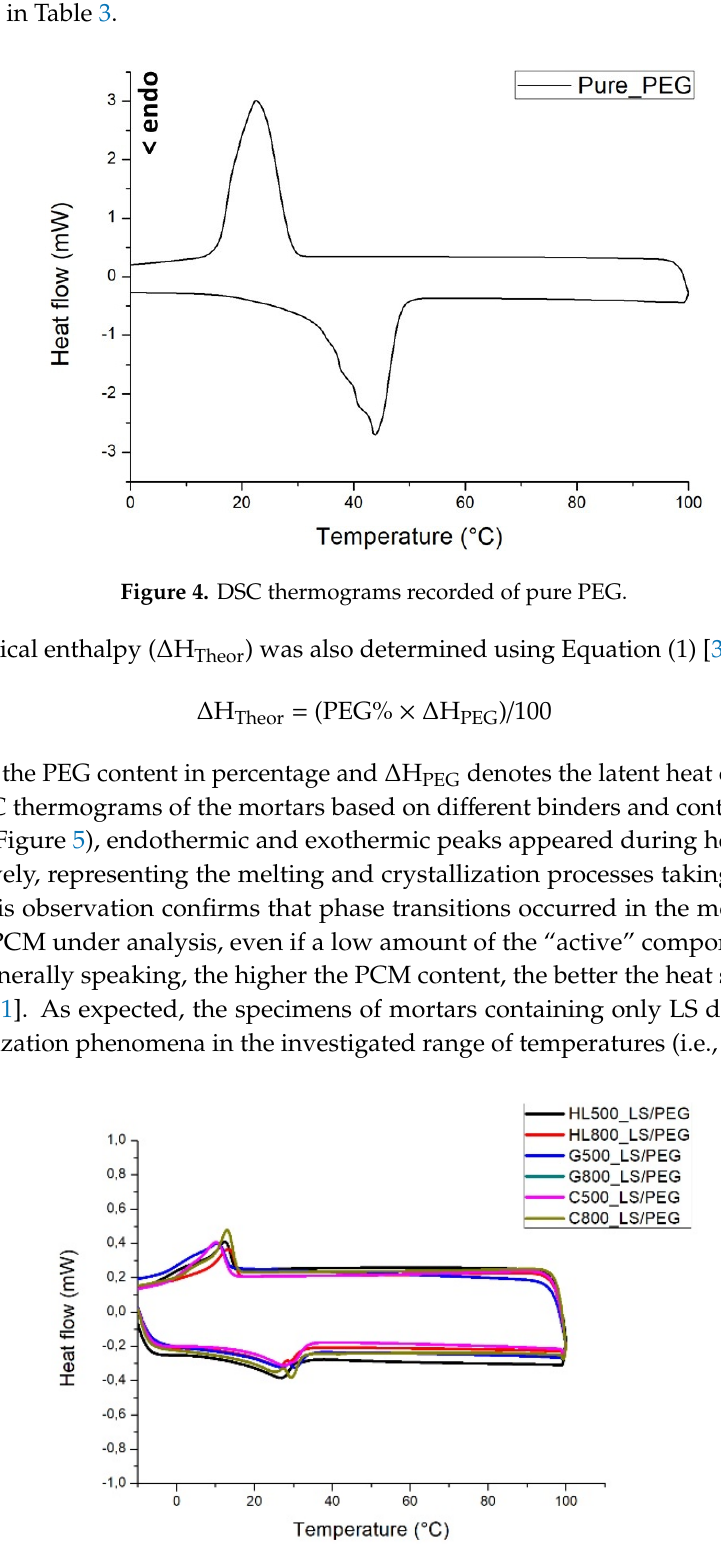
Figure 5. DSC thermograms of mortars containing LS/PEG PCM. Table 3. Characteristic (initial, end and peak) temperatures and enthalpy measured during heating stage (melting) and subsequent cooling stage (crystallization) on pure PEG, on LS/PEG composite and on mortars, based on different binders, containing LS/PEG composite. For each investigated system, the content in PEG as a percentage and the theoretical enthalpies (as defined in Equation (1)), for both melting ( Δ Hm Theor ) and crystallization ( Δ Hc Theor ), are reported.